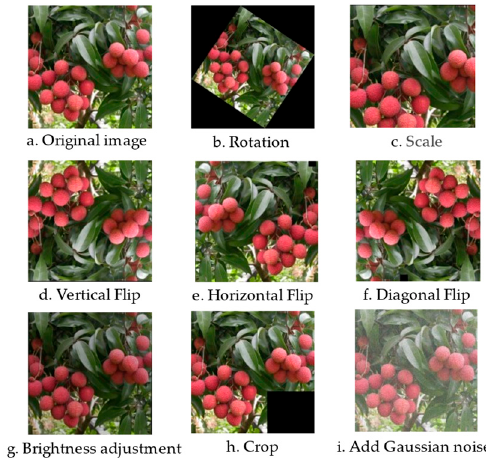
Figure 2. Data augmentation of the dataset.